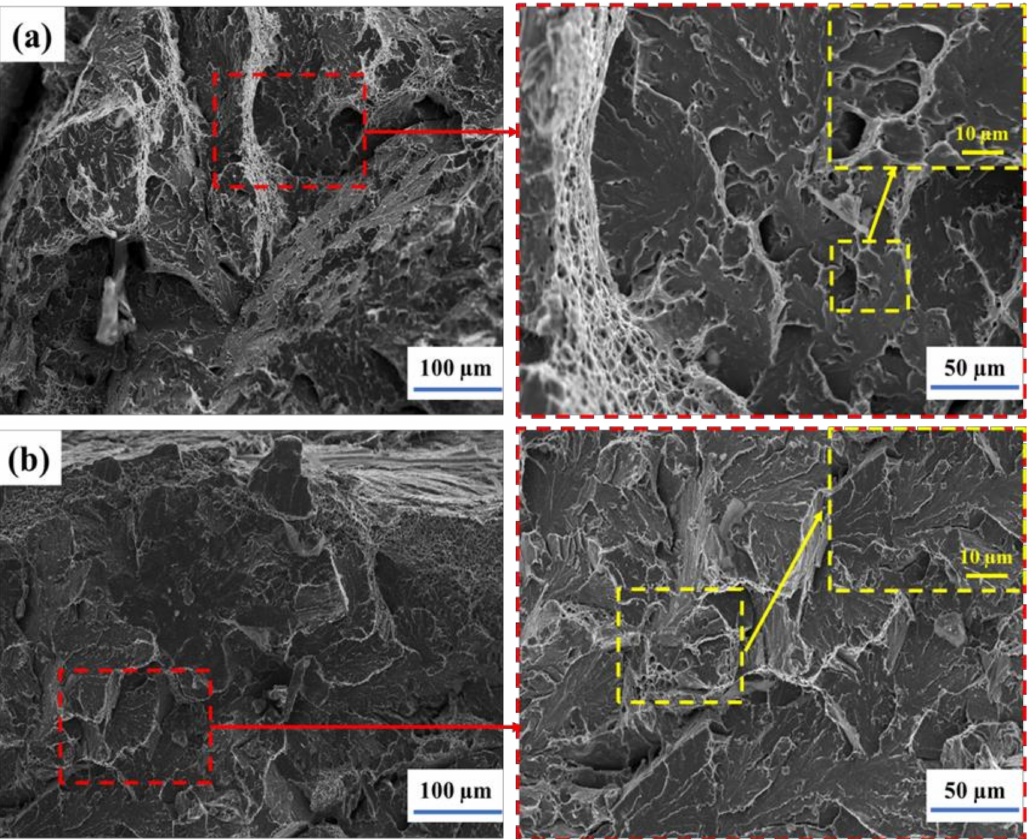
Figure 8. Fracture morphology of weld ( a ) in temper at 660 ◦ C after intercritical normalizing and ( b ) in normalizing after stamp